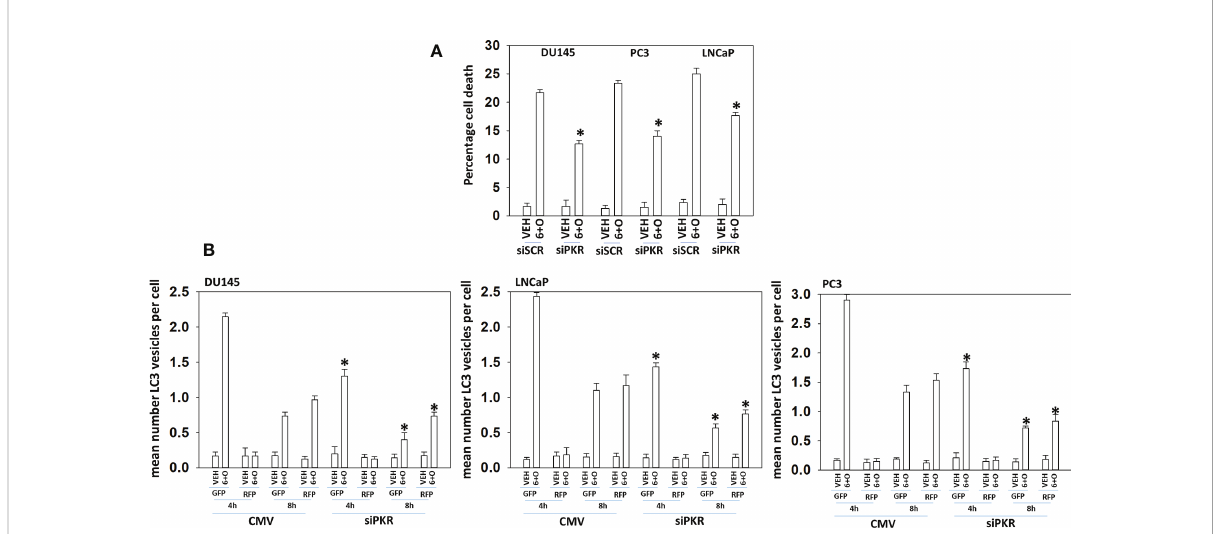
FIGURE 7 Signaling by PKR is required for tumor cell killing and autophagosome formation. (A) Prostate cancer cells were transfected with a scrambled siRNA or with an siRNA to knock down the expression of PKR. Twenty-four h later, cells were treated with vehicle control or with [GZ17-6.02 (2 m M) + olaparib (50 nM)] for 24h. Cells were isolated, and viability determined by trypan blue exclusion assay (n = 3 +/-SD) *p < 0.05 less than corresponding value in vehicle control treated cells. (B) Prostate cancer cells were transfected with a scrambled siRNA or with an siRNA to knock down the expression of PKR and in parallel transfected with a plasmid to express LC3-GFP-RFP. Twenty-four h later, cells were treated with vehicle control, GZ17-6.02 (2 m M), olaparib (50 nM) or the drugs in combination for 4h and 8h. At each time point, the mean number of